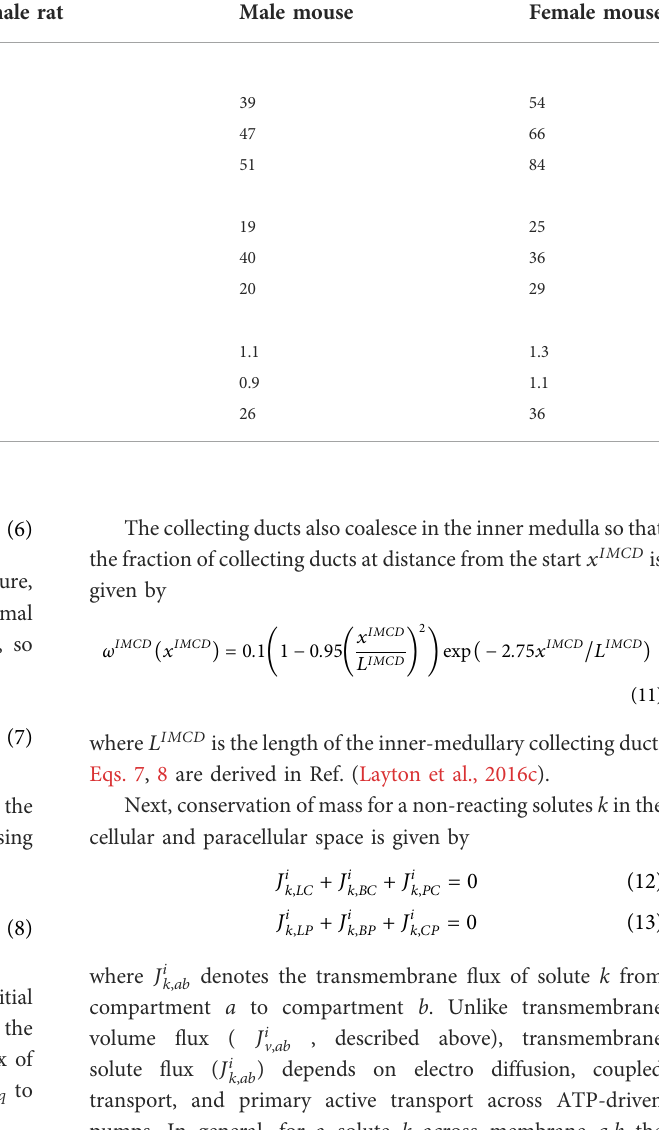
TABLE 2 Predicted fraction deliveries and excretions (%) in the rat and mouse nephron models. Male rat Female